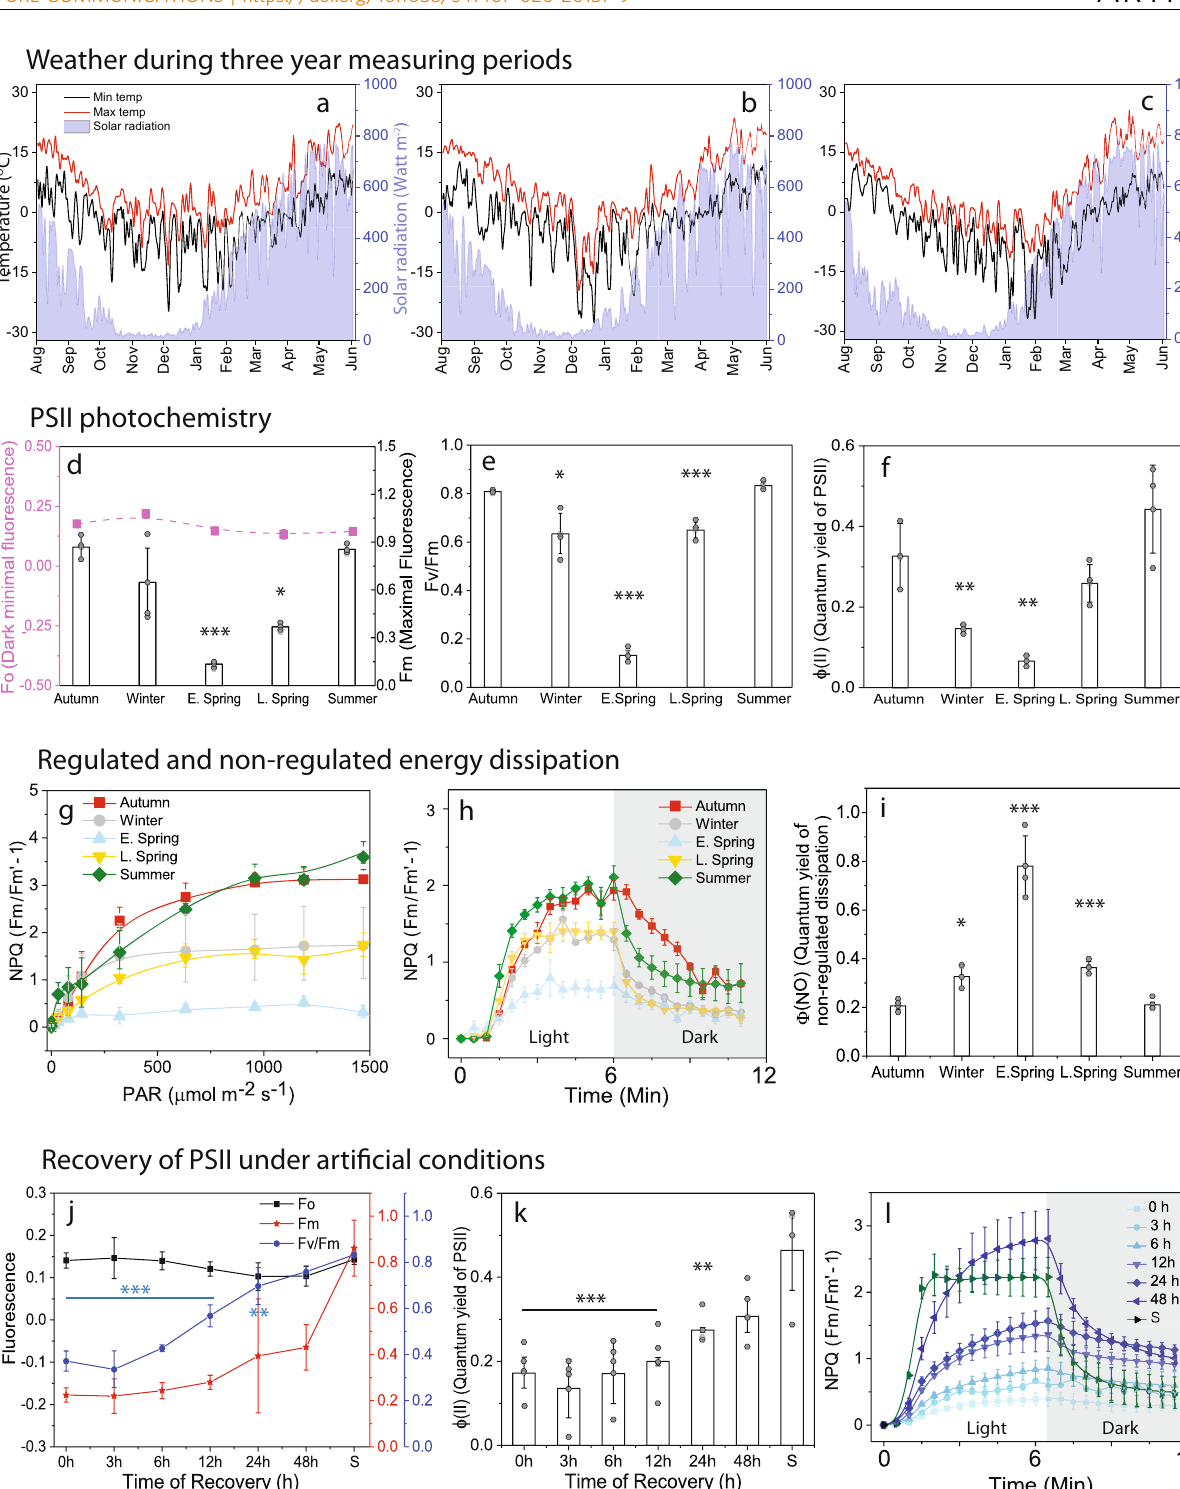
Fig. 1 Seasonal dynamics of weather and photochemical performance of PSII measured by chlorophyll fl uorescence in Scots pine needles. Changes in temperature (°C) (Left Y-axis) and solar radiation (watt m − 2 ) (Right Y-axis) during 2015 – 2016 ( a ), 2016 – 2017 ( b ), 2017 – 2018 ( c ) measuring seasons. Seasonal dynamics of PSII photochemistry: ( d ) Changes in maximal (Fm) and basic (Fo) fl uorescence. ( e ) Maximal quantum ef fi ciency of PSII measured as Fv/Fm ( f ) Effective quantum yield of PSII ( Φ (II)). Energy dissipation measured as regulated and non-regulated non-photochemical quenching: ( g ) Changes in NPQ with increasing PAR. ( h ) Induction of NPQ with constant actinic light. ( i ) Quantum yield of non-regulated non-photochemical quenching. Recovery of pine needles under arti fi cial conditions at 80 µ mol photons m − 2 s − 1 of light for 48h with 18/6 photoperiod: ( j ) Changes in Fo. Fm and Fv/Fm. ( k ) Changes in Φ (II). ( l ) Induction of NPQ with constant actinic light. Quantum yields were calculated at actinic light illumination of 300 μ molm − 2 s − 1 in the light response curve and NPQ induction was measured either at 300/800 μ molm − 2 s − 1 of actinic light illumination. All measurements were taken after 30min of dark adaptation at 4°C from winter to late spring and room temperature in summer. Error bars indicate the mean ± SD ( n = 3) for ( d – g ), and ( i ); ± SD ( n = 4) for ( j , k ). Error bars indicate the mean ± SE ( n = 3) for ( h , l ). The statistically signi fi cant mean differences (t-test) are marked by asterisks indicating the following con fi dence intervals: * ≤ 95%; ** ≤ 99%.; *** ≤ 99.9%. Exact p values are provided in the source data fi